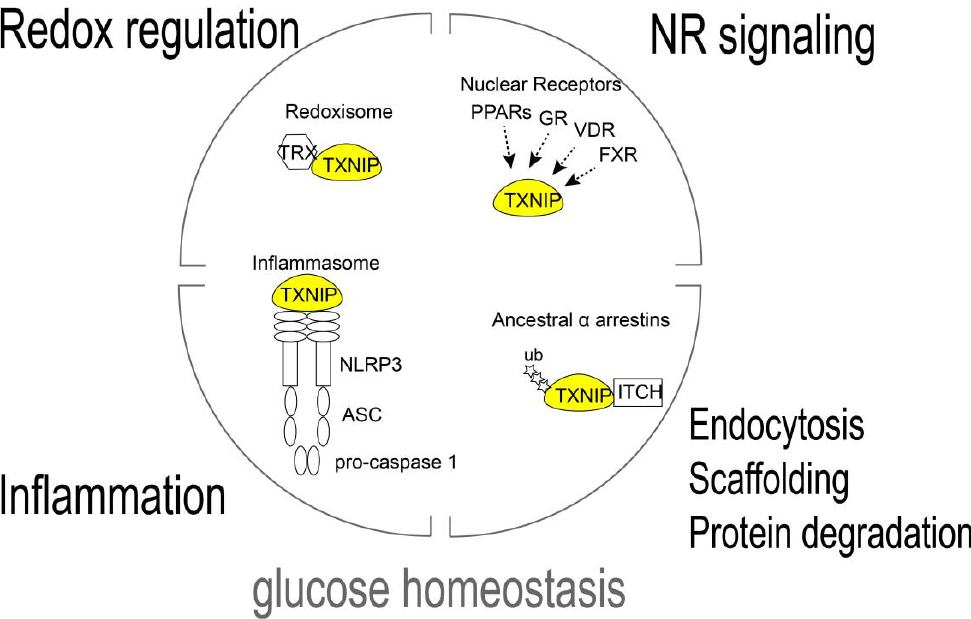
Figure 1. TXNIP regulates glucose homeostasis as signal complex. The TRX / TXNIP signal complex, redoxisome, is the basis of TXNIP regulation of the reduction–oxidation (redox) response. TXNIP has been known to bind NOD-like receptor protein 3 (NLRP3) and activate the inflammasome. TXNIP is a member of the ancestral α -Arrestin family and TXNIP binds to the Itchy E3 Ubiquitin Protein Ligase (ITCH) and facilitates the ubiquitination of the substrates. TXNIP is transcriptionally regulated by nuclear receptors (NRs) such as peroxisome-proliferator activated receptors (PPARs), glucocorticoid receptor (GR), vitamin D receptor (VDR), and farnesoid X receptor (FXR) in a cell type specific manner. These signal complex / transducers are involved in the physiological functions of TXNIP, including the regulation of glucose homeostasis.